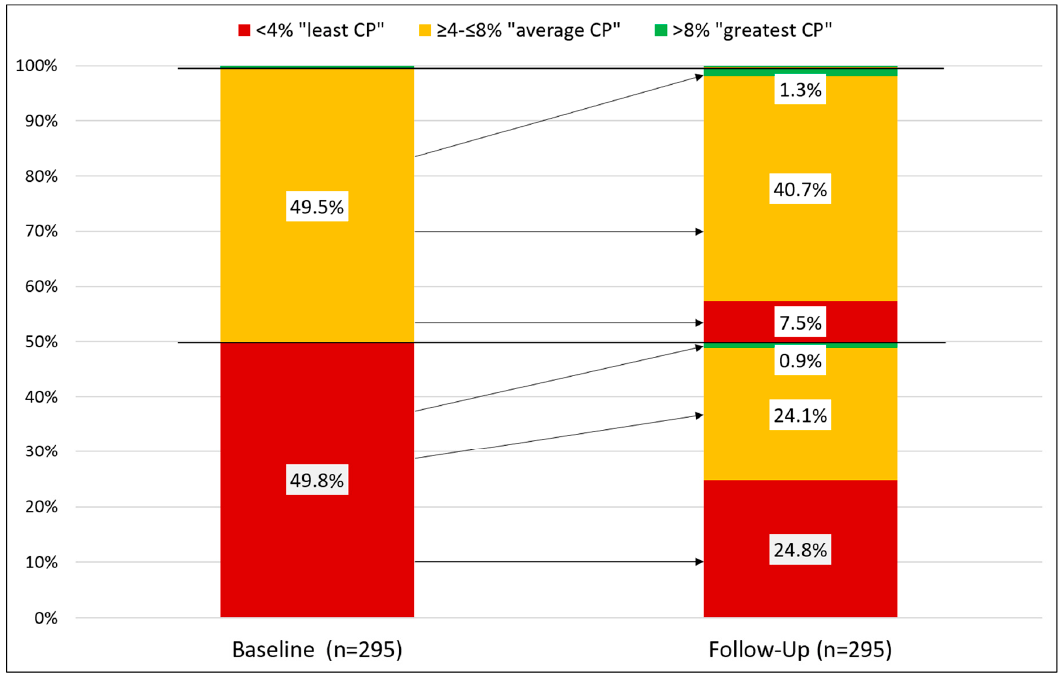
of the study. The gray horizontal line shows the arithmetic mean, the bold, black horizontal line inside the box shows the median. The bottom and top of the box are the bottom and top quartiles of the distribution. The length of the black, vertical “whiskers” corresponds to the 5th and 95th percentile of the variable. The quantile plots the ordered values of the respective variables (ordinate) against the cumulative probability (abscissa). For illustrative purposes, horizonal dispersion (“jitter”) was added to the individual datapoints.